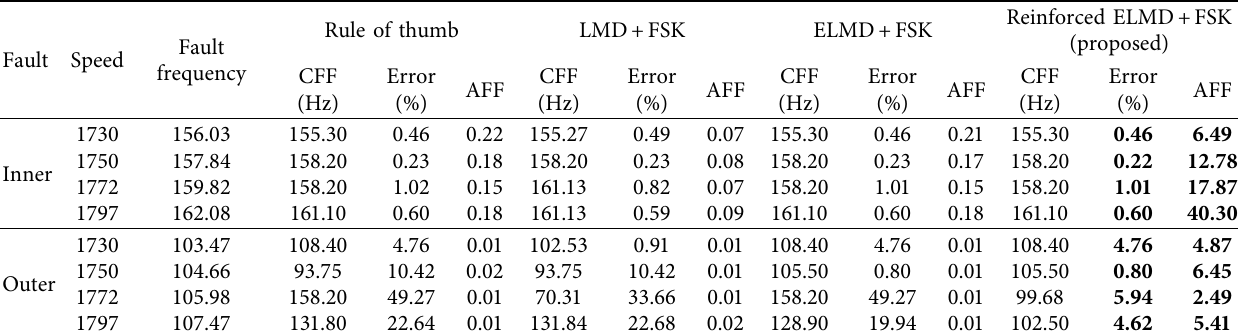
Figure 8: Envelop analysis of the reconstructed signal only using the selected components. Table 2: Identification accuracy comparisons between the proposed method and its counterparts under different operating conditions of CWRU